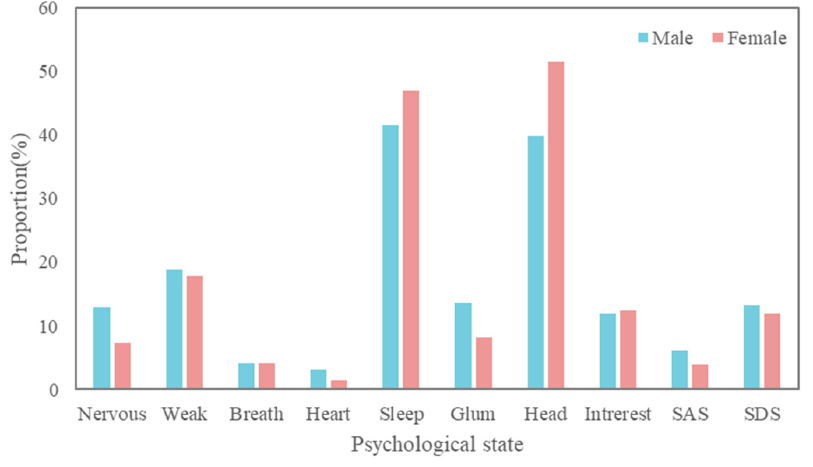
Figure 15. Gender differences in psychological state.